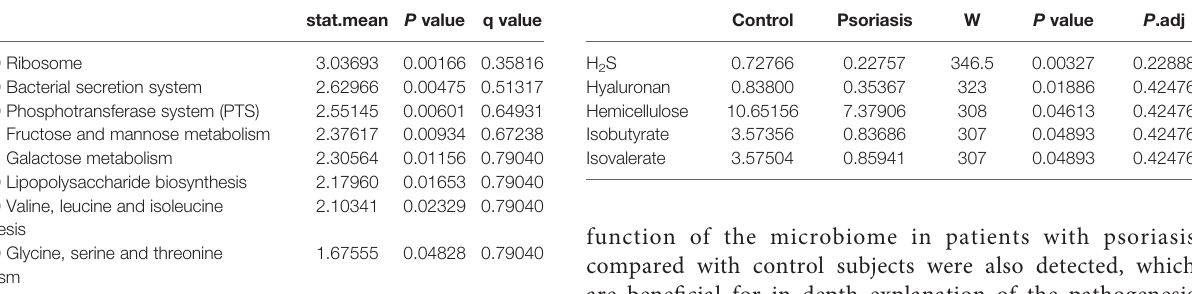
TABLE 4 | Dysregulated metabolites in psoriasis